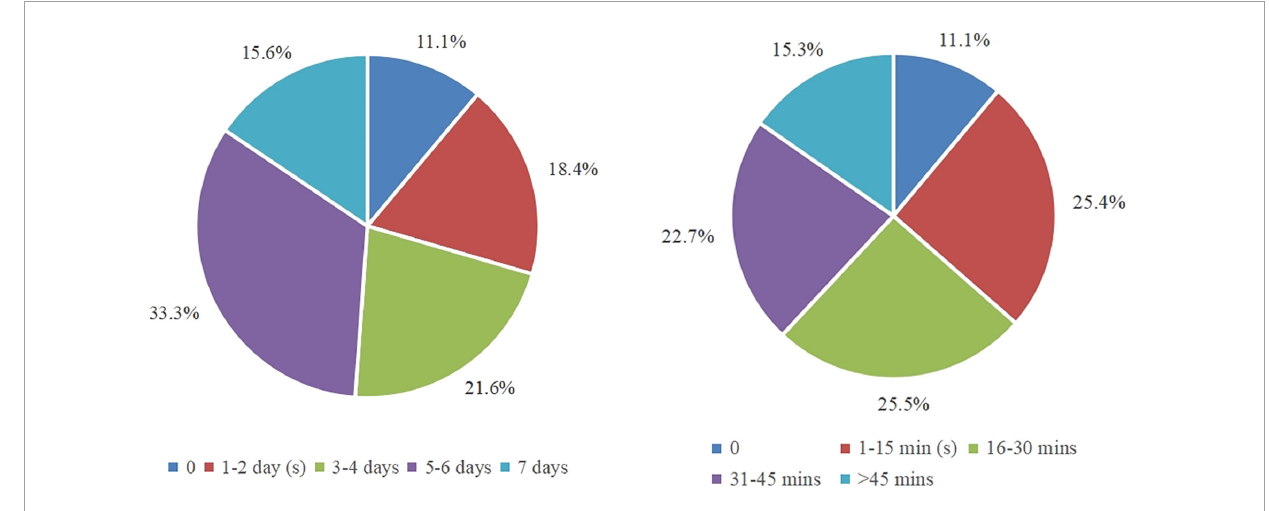
FIGURE1 Percentage distributions of the days and duration of textbook